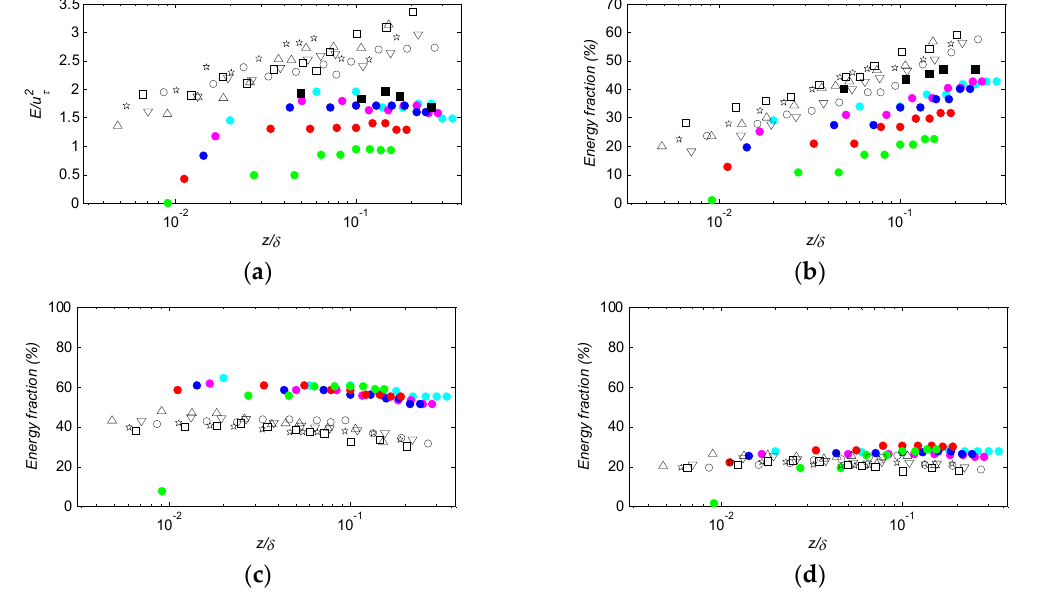
Figure 13. Variations in the total energy ( a ) and energy fraction of VLSMs ( b ) and LSMs ( c , 0.3 δ < λ < 3 δ ; d , δ < λ < 3 δ ) with height. Solid colored circles are current simulation data, the open symbols represent the field-measured data of Wang and Zheng [9], and the solid black symbols give the experimental data of Balakumar and Adrian [2].